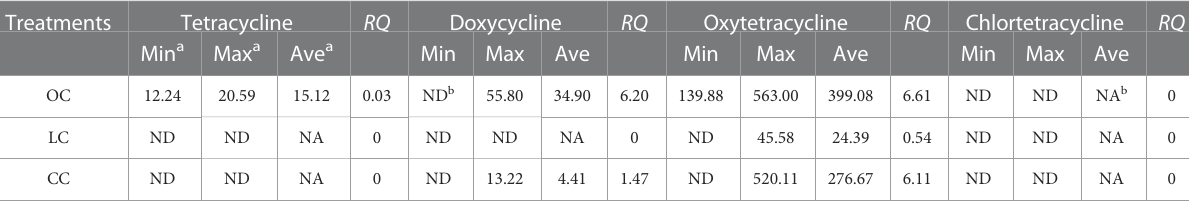
TABLE 1 Soil antibiotic residues in different cultivation/ m g kg -1 . Treatments Tetracycline